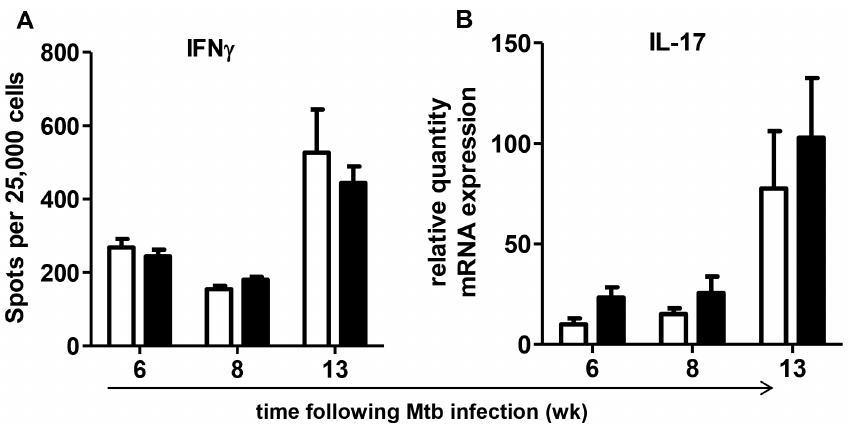
Figure 3. Similar IFN c and IL-17 levels in WT and TLR2KO Mtb-infected mice. Single cell suspensions from lungs of WT and TLR2KO mice were re-stimulated overnight with Mtb-pulsed WT bone marrow-derived dendritic cells and the frequencies of Mtb-specific IFN c -producing cells were determined by ELISPOT (A). Expression levels of IL-17 (B) in the lungs of WT and TLR2KO mice during Mtb infection were determined by isolation of total lung RNA followed by real time RT-PCR analysis. Each time point in A and B includes 4–5 mice per group, and data are representative of two independent experiments. All data are presented as mean 6 SEM. No significant differences were observed between the WT and TLR2KO mice.